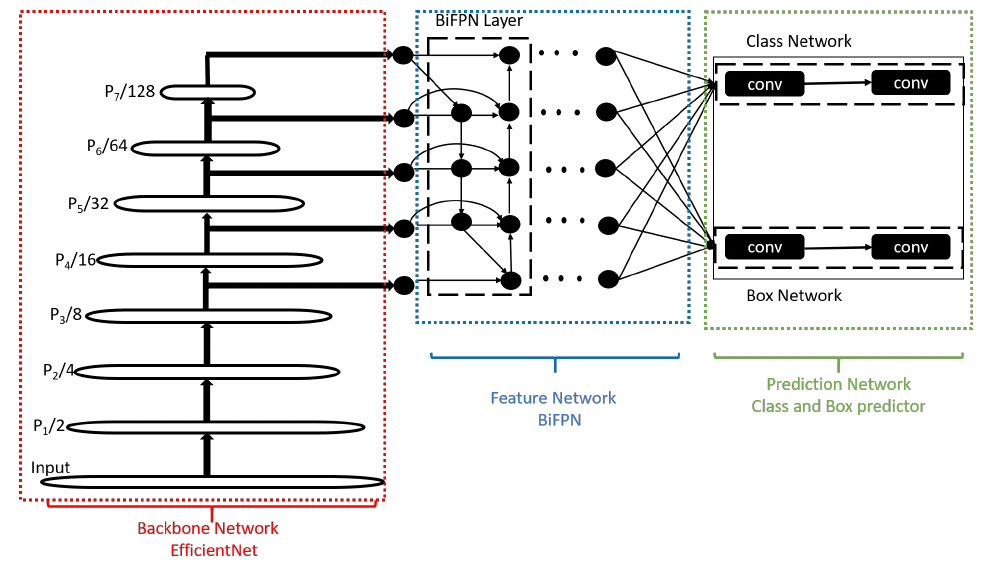
Figure 7. The architecture of EfficientDet model [39].